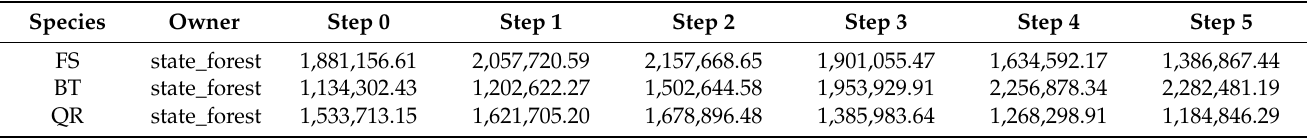
Table A3. Results from calculations conducted in EFDM software. Drain volume [m 3 ] by ownership type and species. Simulation in the time period (2010–2030), divided into 5-year simulation